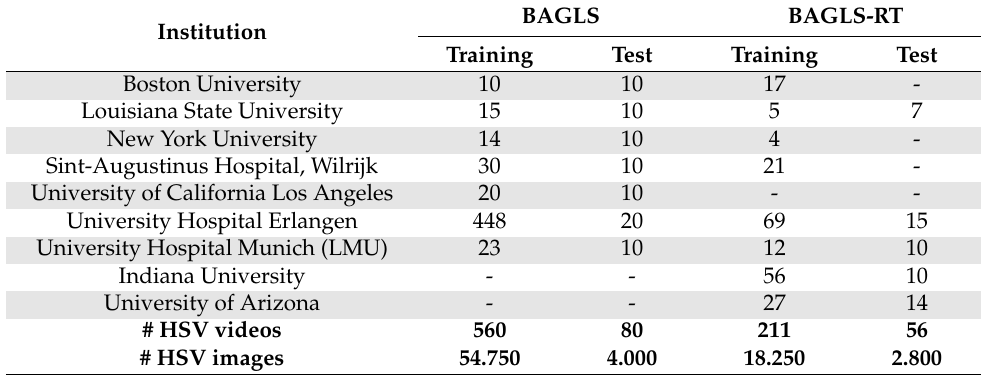
Table A2. Distribution of HSV data by institutions.